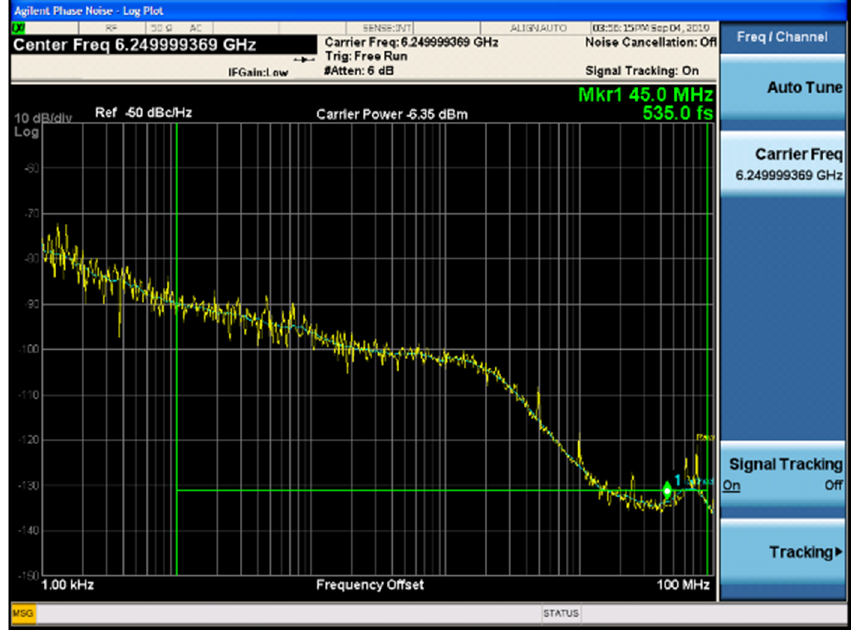
Figure 10. LC PLL output noise test results.